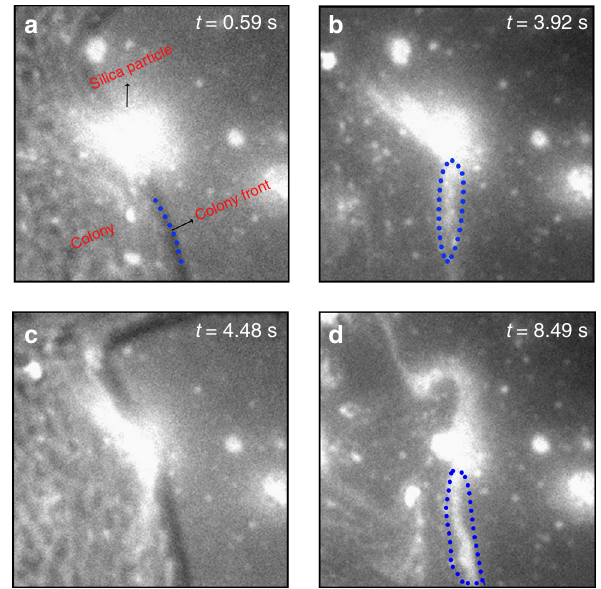
Fig. 6 Visualizing MIMS in real-time. Wide- fi eld fl uorescence microscopy images of a dye-labelled copolymer 3 -coated silica particle at ( x = 50 μ m, y = 83 μ m) in Supplementary Movie 1. a , c Show the overlap of the swarmer colony and labelled copolymer 3 recorded with white and red light irradiation, respectively, and b , d show only the images of copolymer 3 . Examples of fl uorescent streaks arising from removed copolymer 3 are enclosed within blue dotted lines in ( b ) and ( d ). The time of each image t is given. The image contrast is enhanced resulting in particles